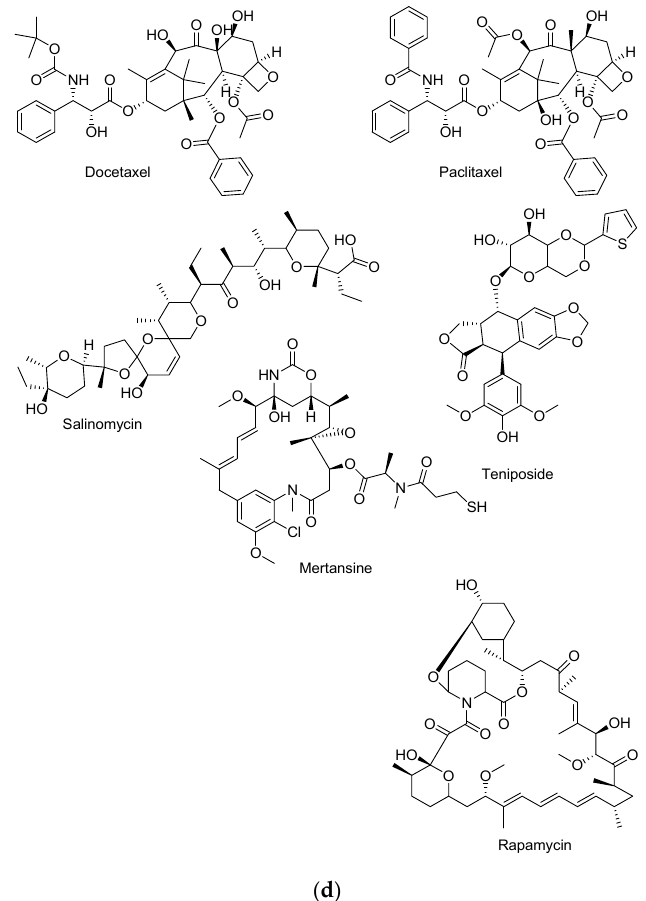
Figure 3. ( a ): Schematic diagram of polymeric micelles. ( b ): A schematic diagram illustrating the uptake of micelles formulation into tumor cells. ( c ): Structures of some anticancer drugs loaded into micelles. ( d ): Structures of some anticancer drugs loaded into micelles.